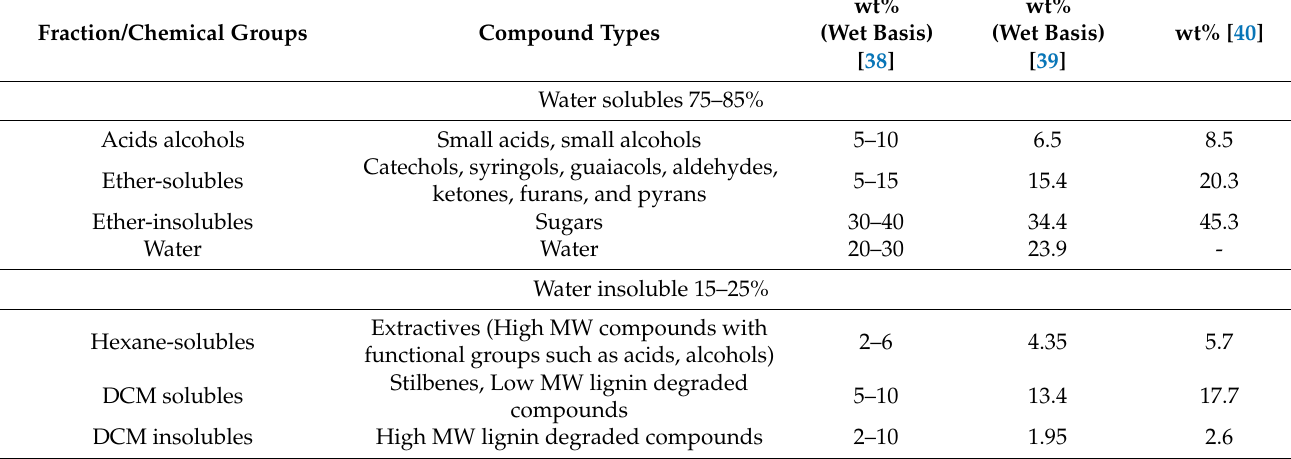
Table 1. Bio-oil composition.